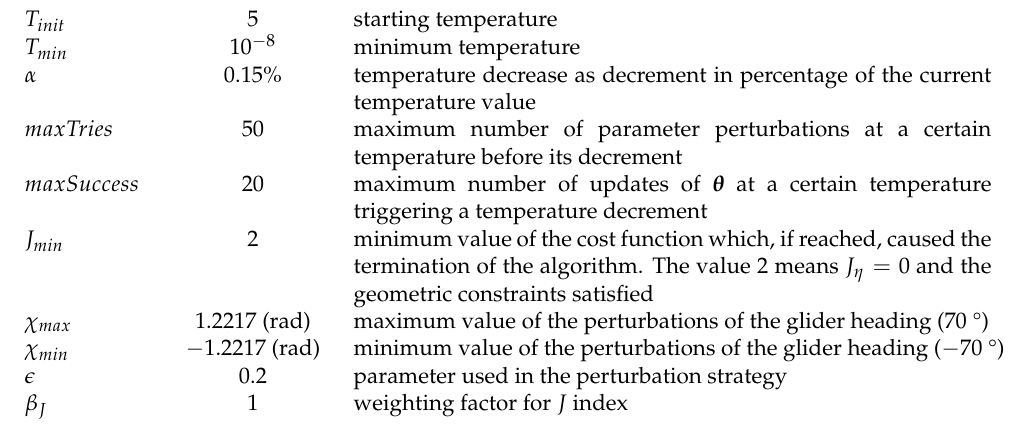
Figure 3. Values of the prior variances of the grid mesh nodes (diagonal values of the prior covariance matrix Σ in the area of study). The red marker represents the starting position used for the gliders (38.0654° N, 5.16° E). Table 3. Parameters used for the optimization